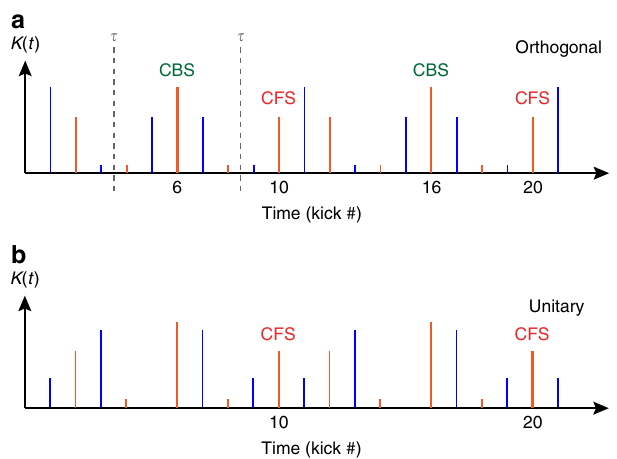
Fig. 5 Two pulse sequences belonging to different symmetry classes. The sequences correspond to the data shown in Fig. 2, and were obtained using two different values of the symmetry-control parameter ~ φ in (5): ~ φ ¼ 0 ( a ) and ~ φ ¼ (cid:2) 3 π = 5 ( b ), for which the system belongs respectively to the orthogonal and unitary symmetry class. In the orthogonal class the time sequence has symmetry axes τ ; a CBS peak will appear at the kicks symmetric to the initial kick with respect to such axis. In the unitary class no CBS peak will exist. In both cases, the symmetry-insensitive CFS peaks are expected to occur at integer multiples of the period ( N =